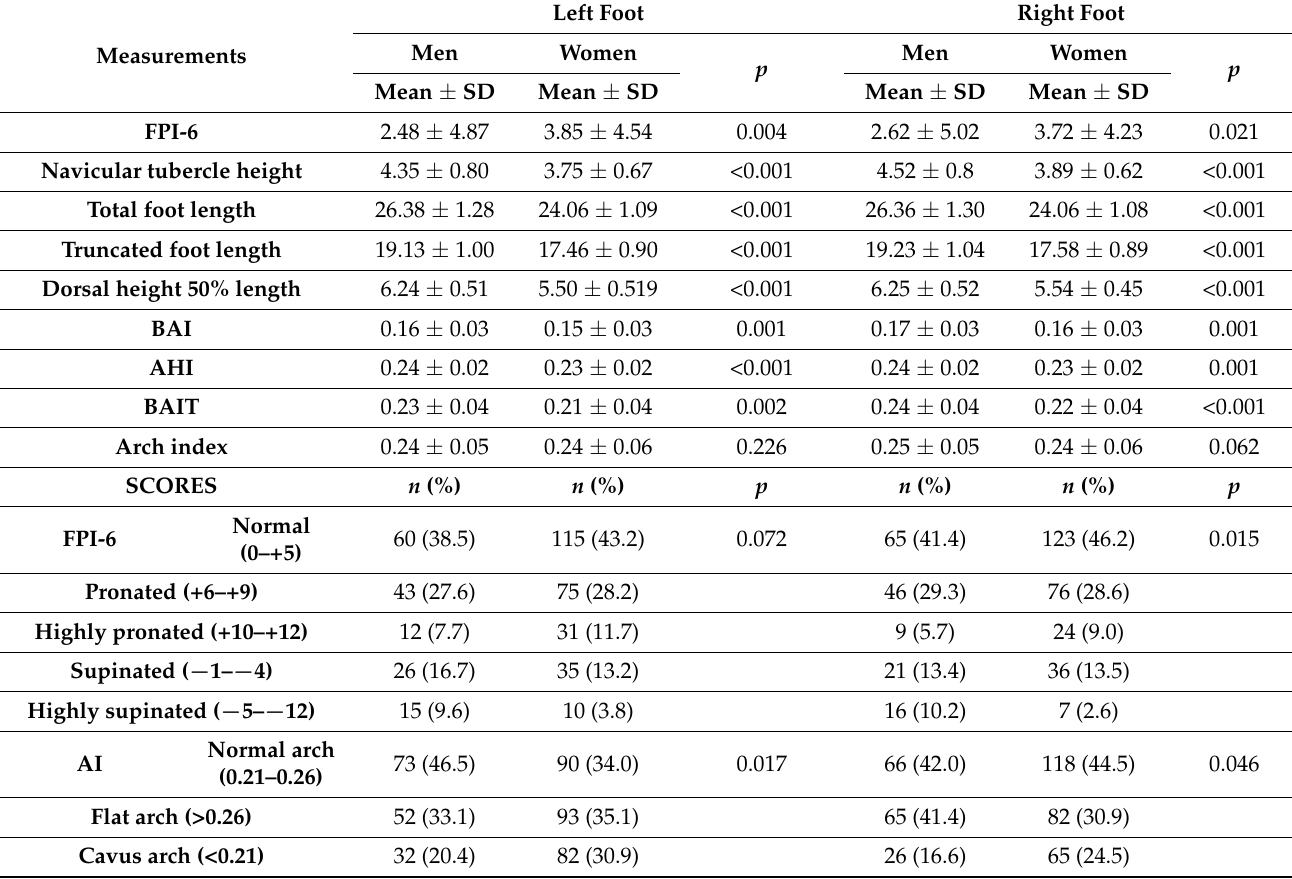
Table A4. Differences in medial longitudinal arch morphology according to gender.